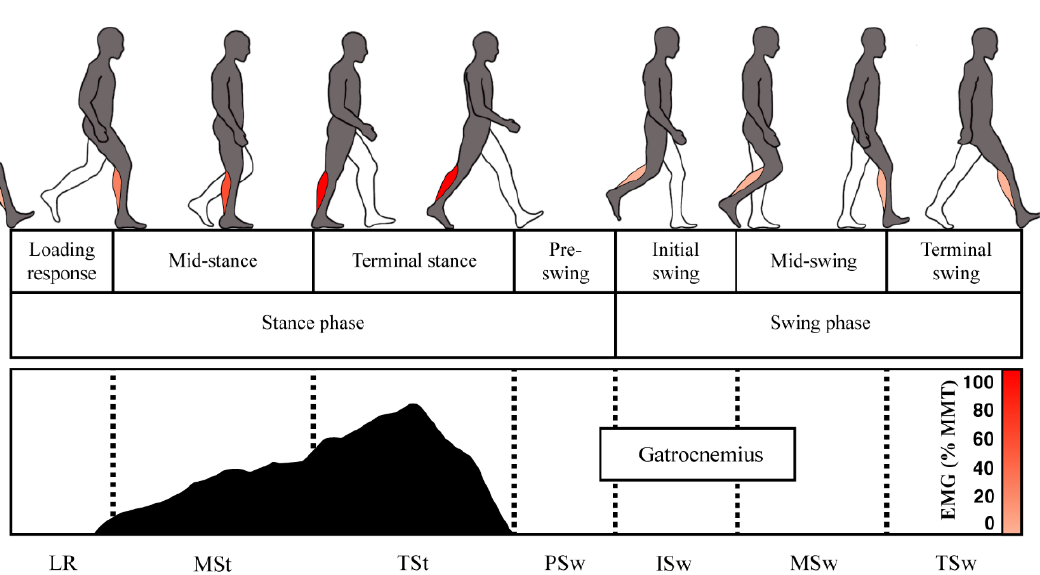
Figure 2. Muscle activity of gastrocnemius for each gait cycle section. Gastrocnemius is most activated in the section from terminal stance to pre-swing and plays a role in moving the body forward by performing plantar flexion.